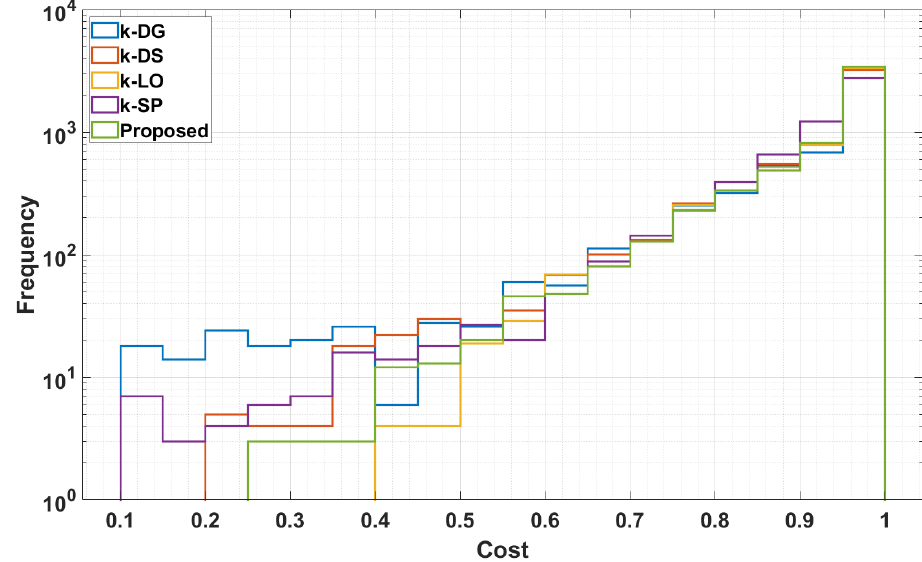
Figure 2. Histogram plot of the attackers’ costs of launching DDoS Attack on an LEO satellite network.